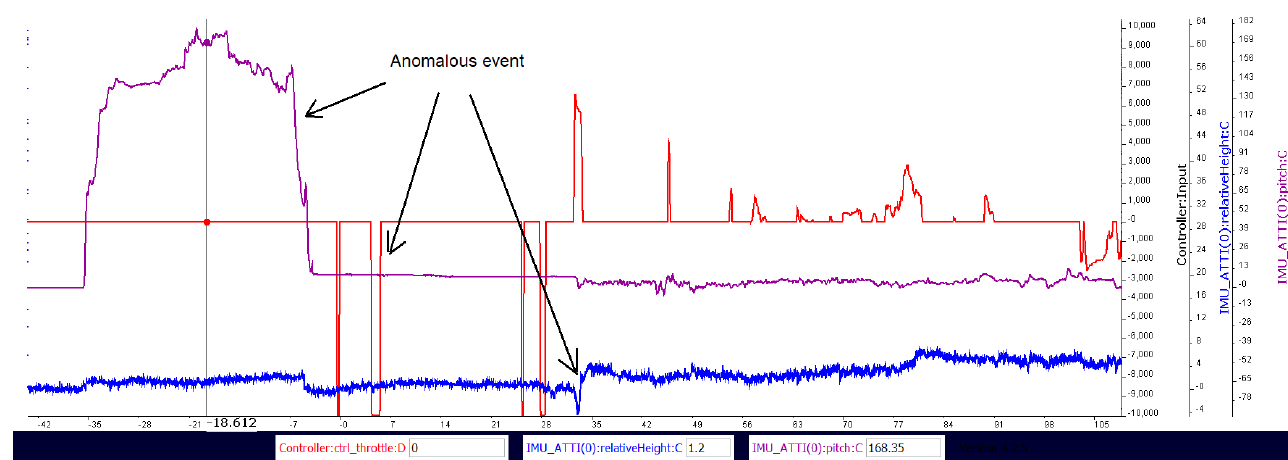
Figure 4. Abnormal operations in flight-log-19.